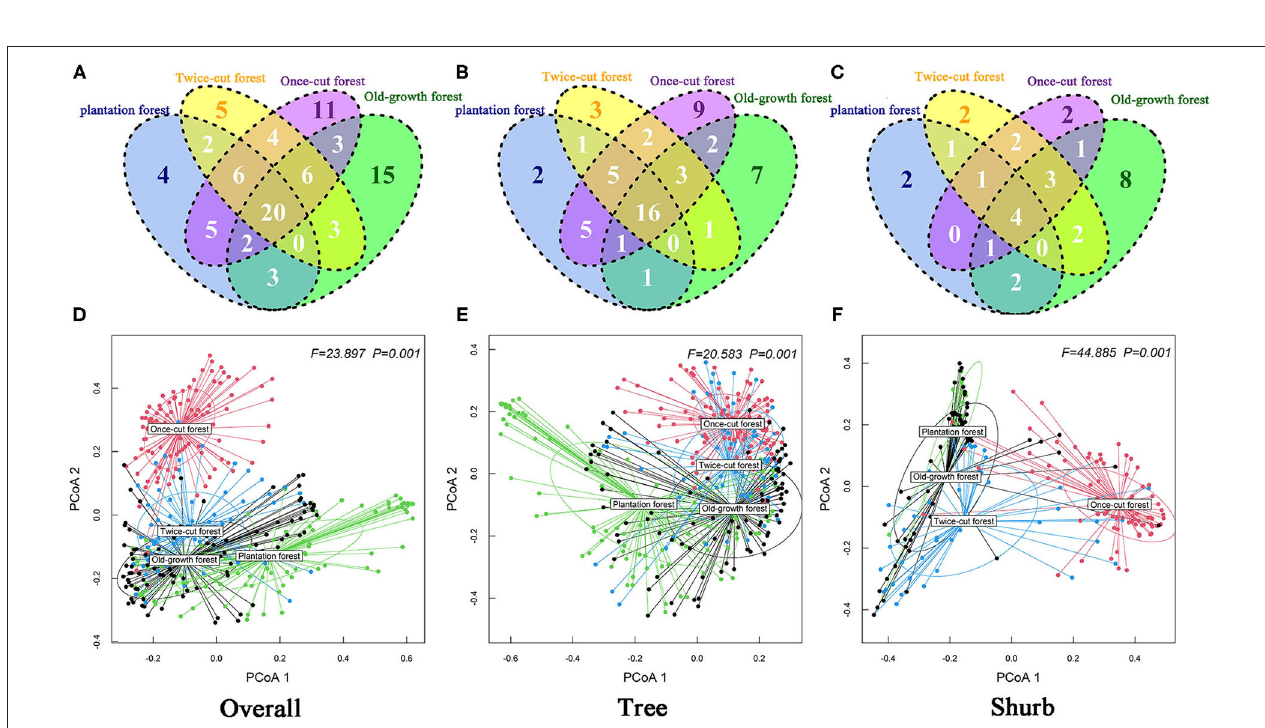
FIGURE 5 | Degree of overlap of the species composition in the four communities ( A : Overall; B : Tree; C : Shurb). Effect of community types on beta diversity of the woody plant by running the betadisper function. ANOVA was conducted to test how these distances differ among community ( D : Overall; E : Tree; F : Shurb). PCoA1 and PCoA2 are the first and second sort axes in the “betadisper” analysis, respectively.